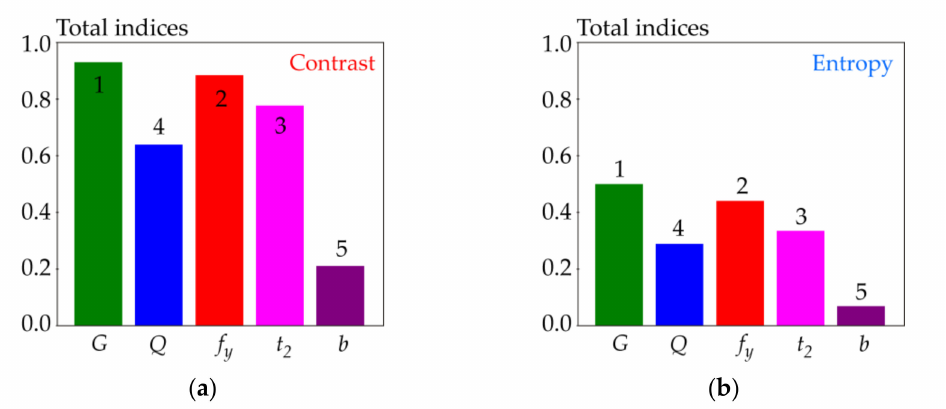
Figure 14. Total indices for P f = 7.2 × 10 − 5 using: ( a ) C M ( P f ), Equation (23); ( b ) E M ( P f ), Equation